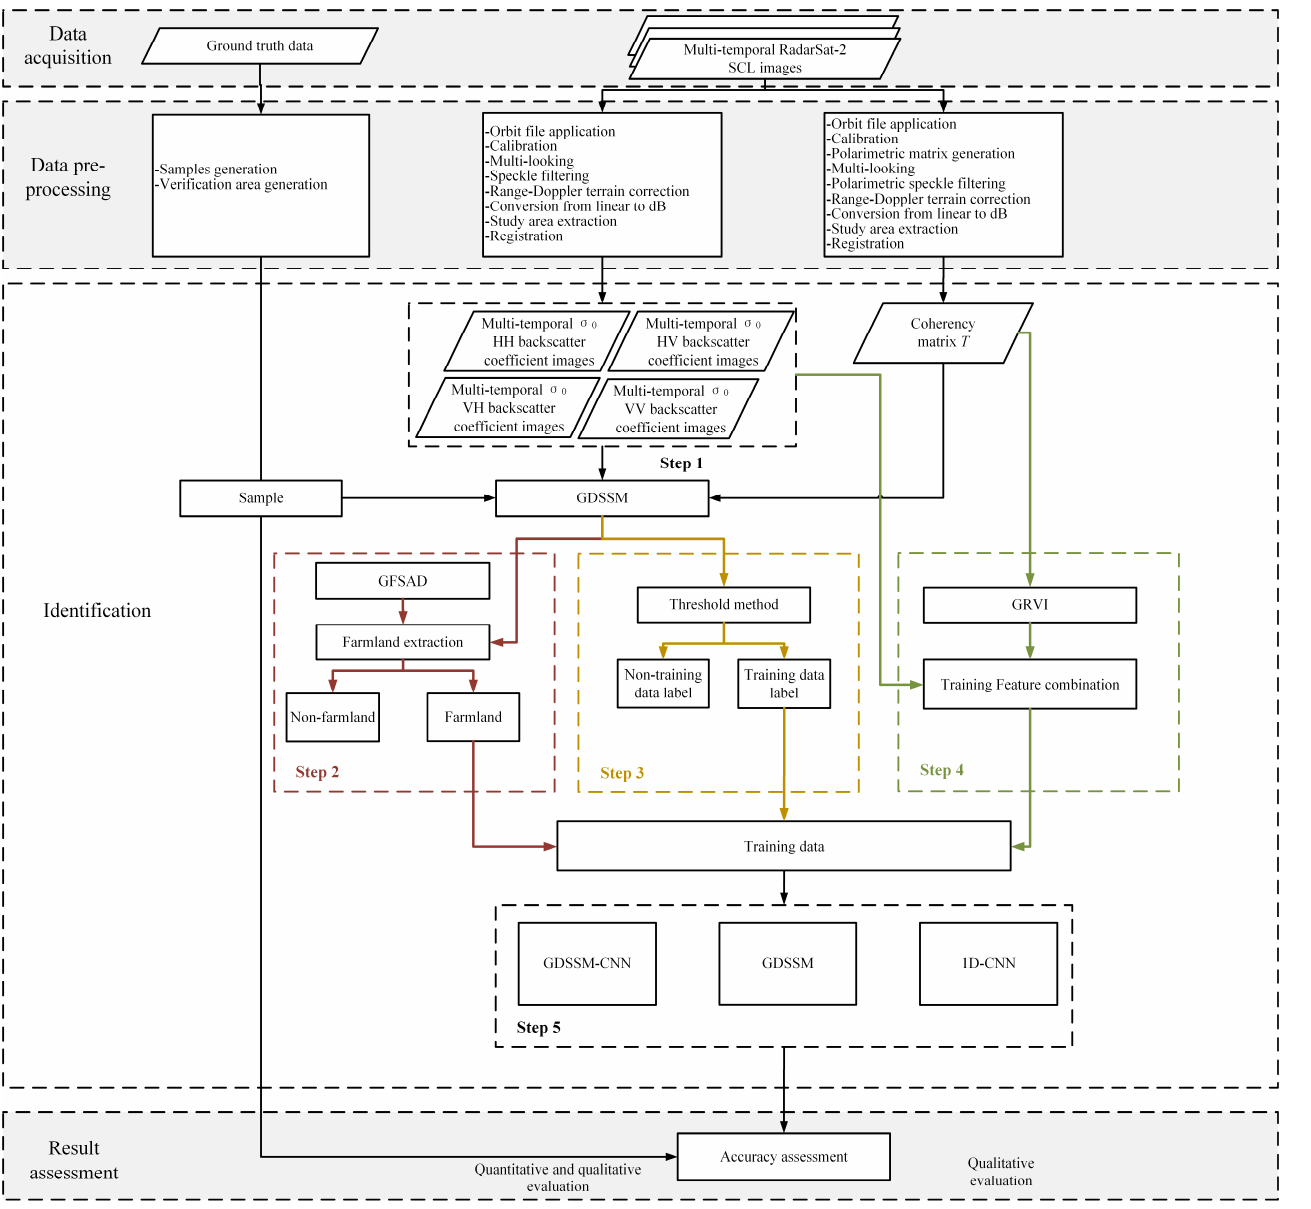
Figure 2. Flow chart of the proposed method.